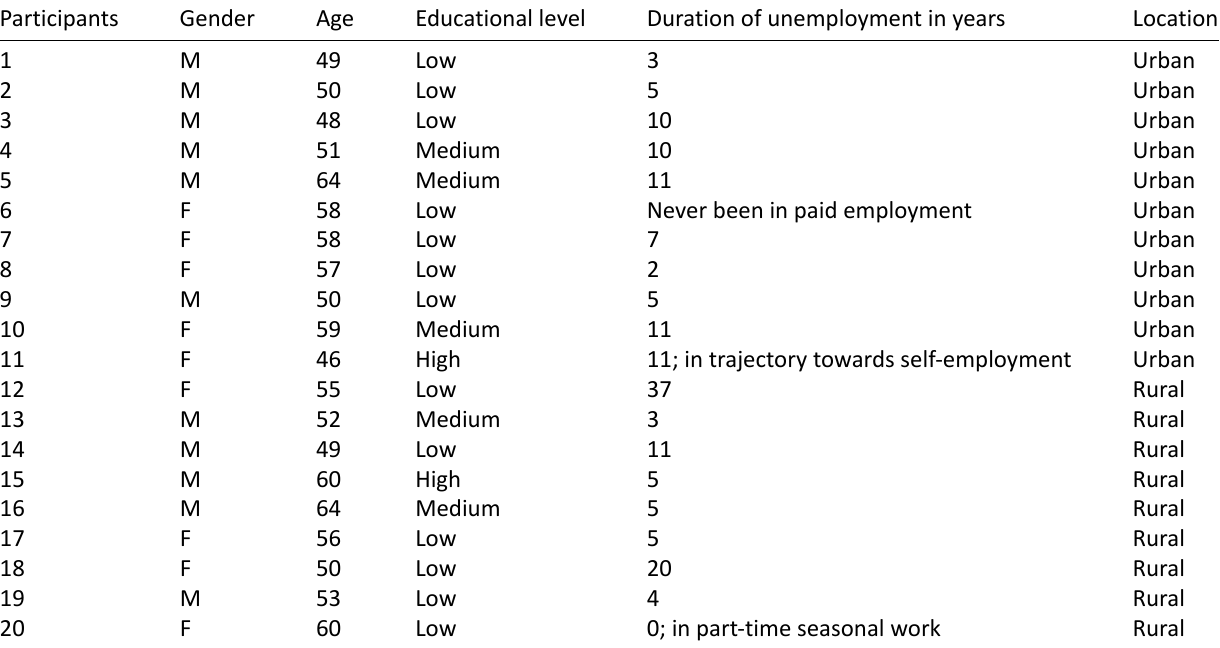
0; in part-time seasonal work